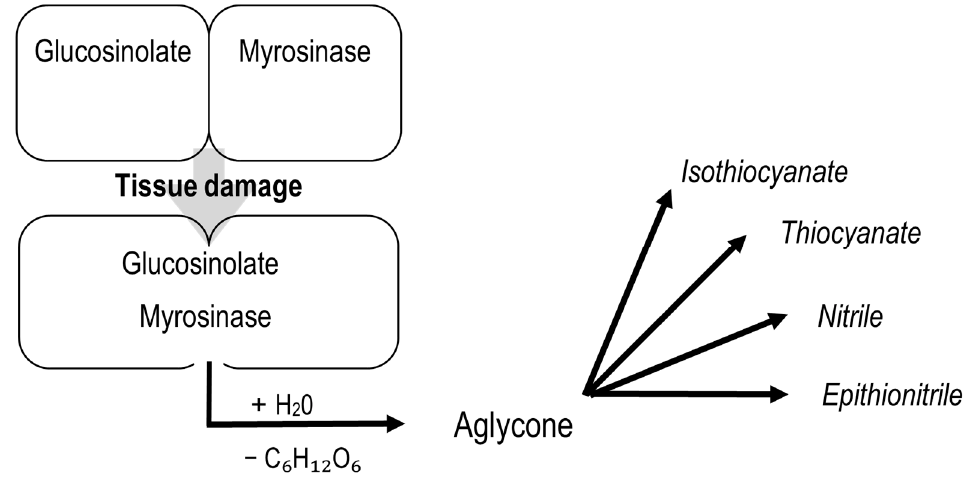
Figure 1. Degradation of glucosinolates in plant cells.